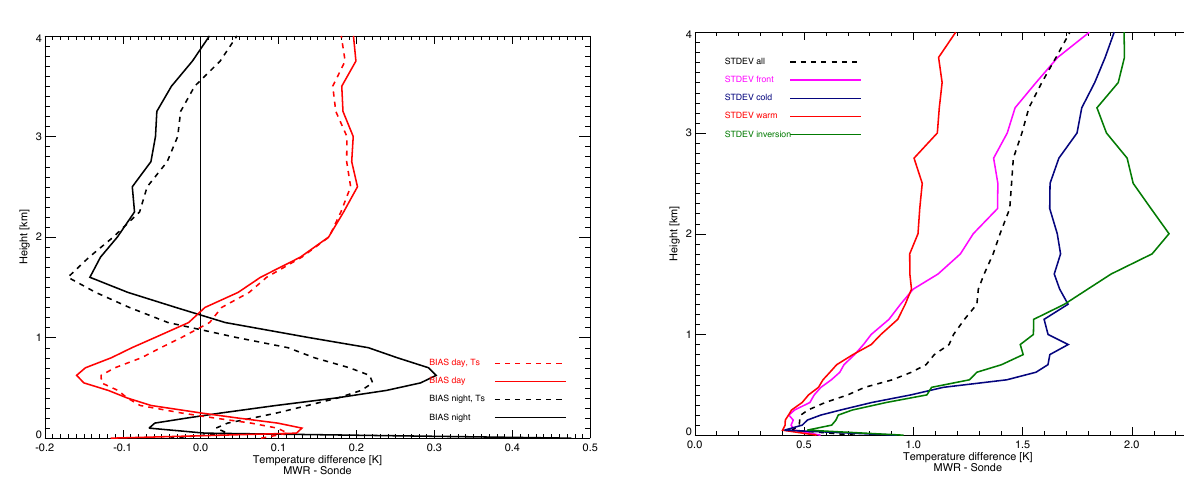
Fig. 11. Temperature profile differences (BIAS) during all-sky con- Figure 11: Temperature profile differences (BIAS) during all-sky conditions from August 2006 – 694 ditions from August 2006–December 2009 between MWR and ra- December 2009 between MWR and radiosonde measurements differentiated by day and night; red 695 diosonde measurements differentiated by day and night; red lines lines show the retrieval results only at 12 UTC, whereas black lines only at 0 UTC. 920 12 UTC, 696 show the retrieval results only at 12:00UTC, whereas black lines respectively 896 0 UTC MWR measurements passed the quality control and are evaluated in the plot. 697 only at 00:00UTC. 920 12:00UTC, respectively 896 00:00UTC Dashed lines show retrieval results using 2m-temperature (Ts) as an additional predictor in the linear 698 MWR measurements passed the quality control and are evaluated in the plot. Dashed lines show retrieval results using 2m-temperature regression. 699 (Ts) as an additional predictor in the linear regression.